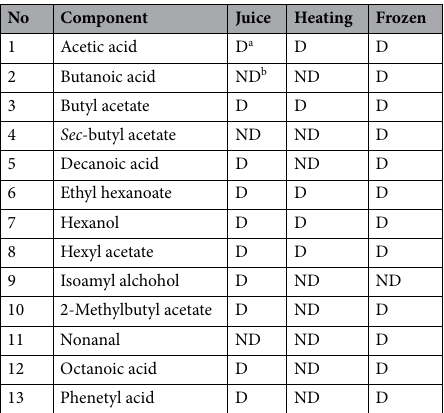
Table 1. Comparison of flavor detection in intact juice (Juice), heated concentrate (Heating), and frozen concentrate (Frozen). a Detected. b Not detected.